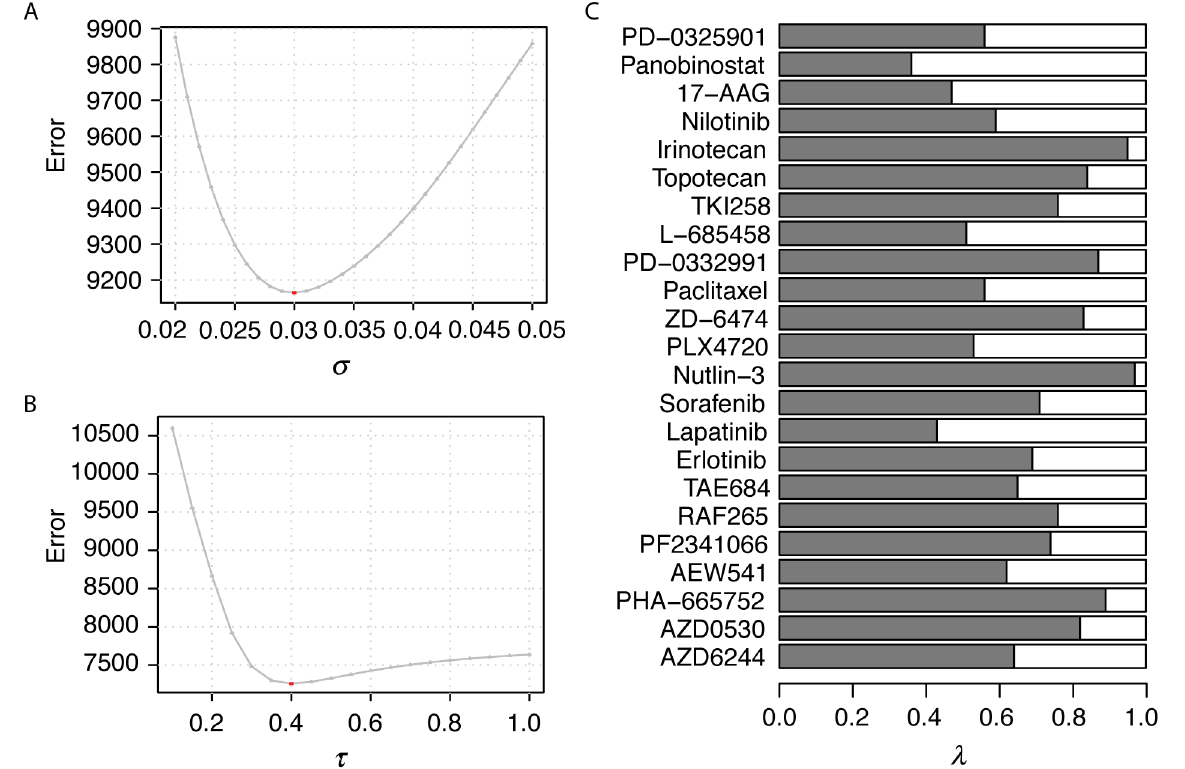
Fig 3. Parameter optimization for the dual-layer integrated cell line-drug network model. Using the CCLE study as an example, two bandwidth parameters, σ for the CSN (A) and τ for the DSN (B), were optimized separately. The optimized weighted parameter, λ , was determined for each of the 23 drugs in the CCLE study